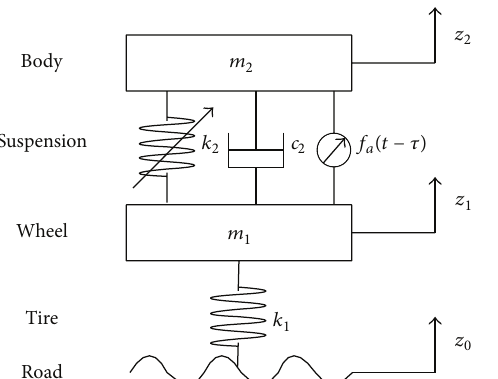
Figure 1: Quarter-vehicle model with a magneto rheological active suspension.